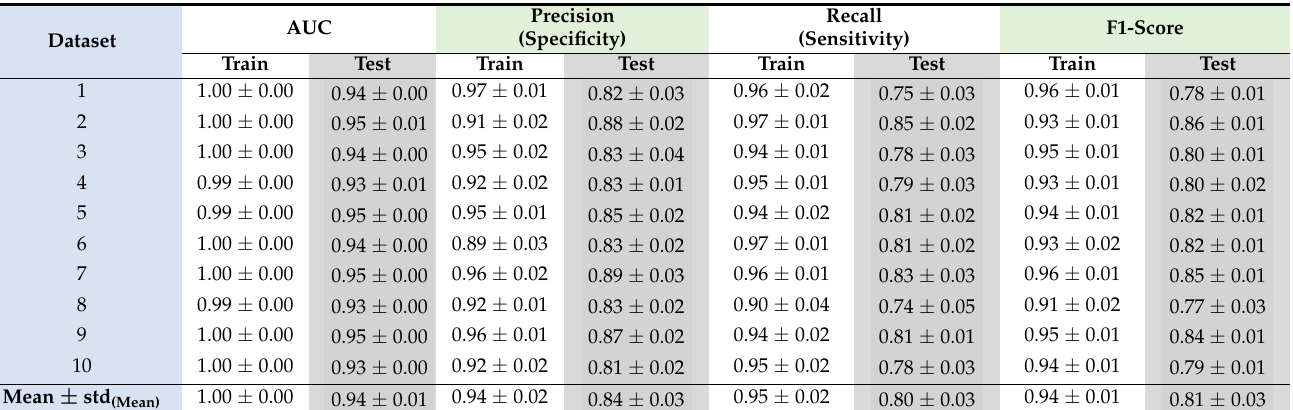
Table 3. AUC, Precision, Recall, and F1-Score calculated from the (spatial sub-model) U-Net’s results for the ten generated